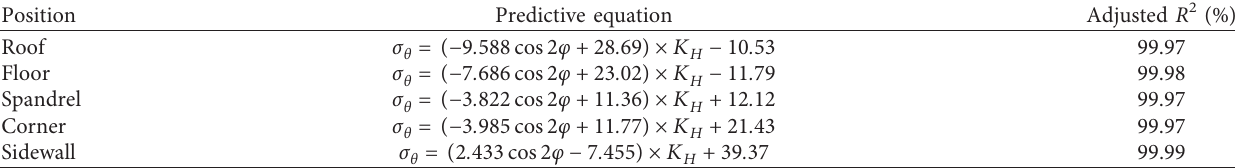
Table 3: The predictive equations and their adjusted R 2 values at key positions. Position Predictive equation